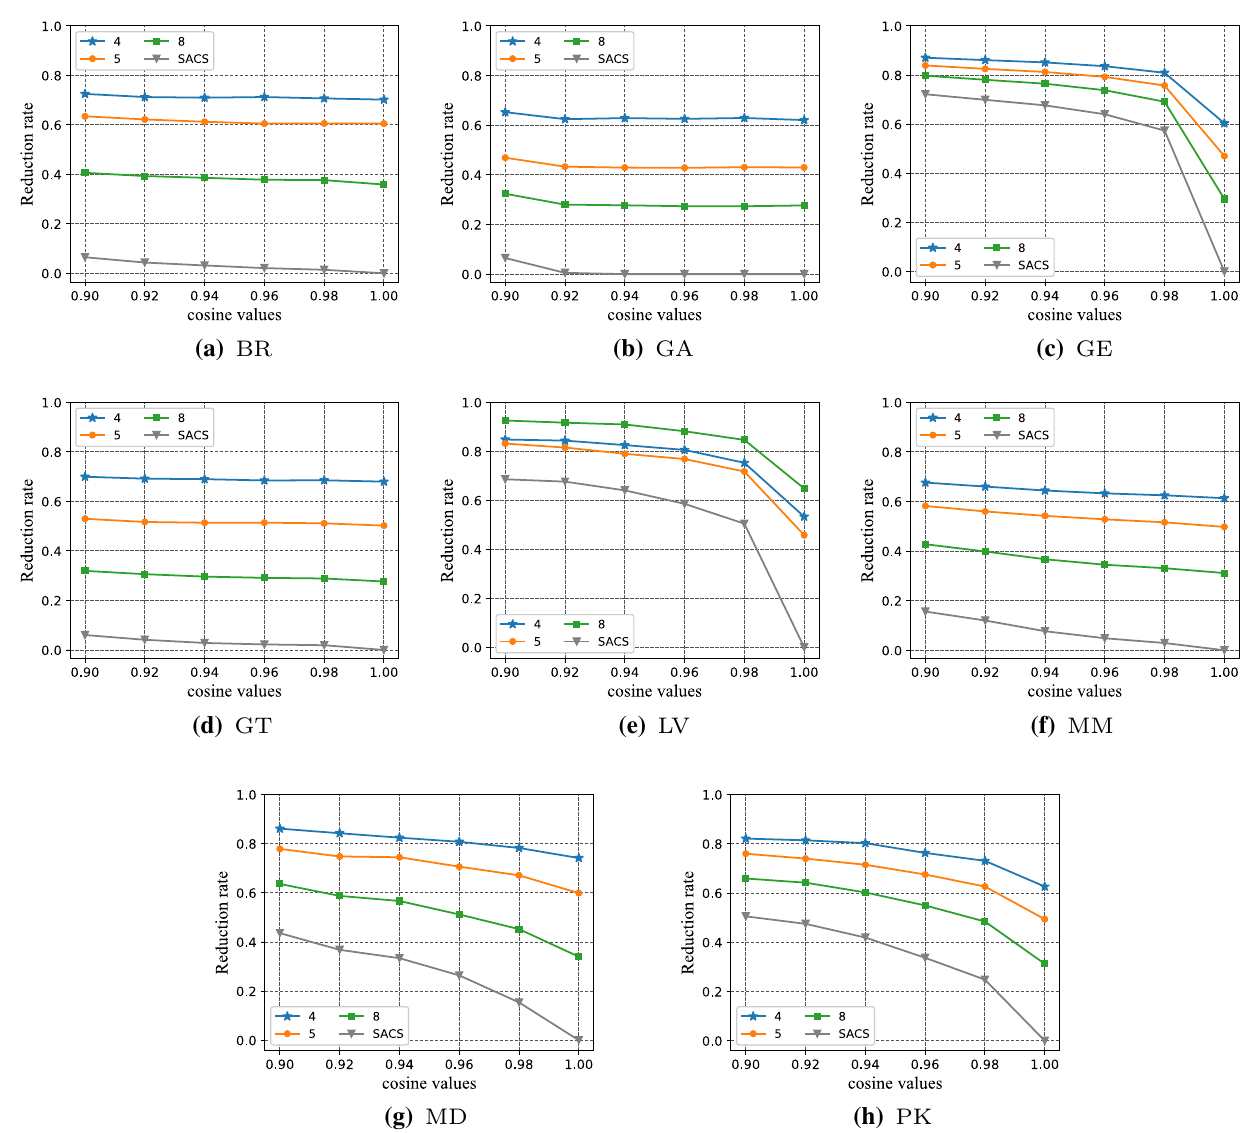
Fig. 2 Reduction rate for the eight datasets with different cosine values. ( SACS represents the result of selecting attributes of the algorithm 1 under different cosine values settings. The 4, 5, and 8 indicate the number of attributes in each partitioned data